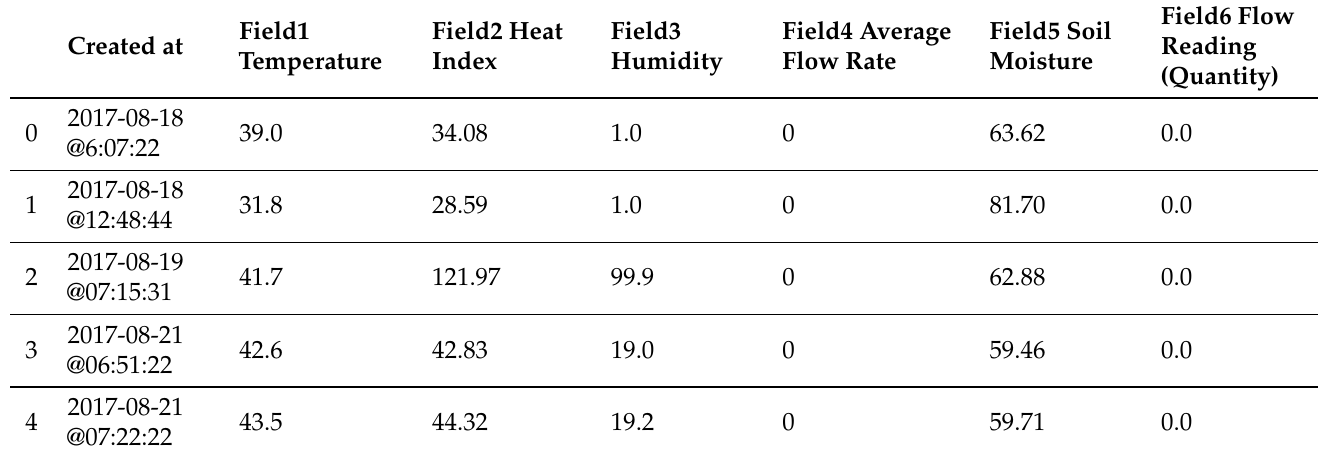
Table 1. Data captured from multiple fields at time steps. Physical sensors were used to obtain the